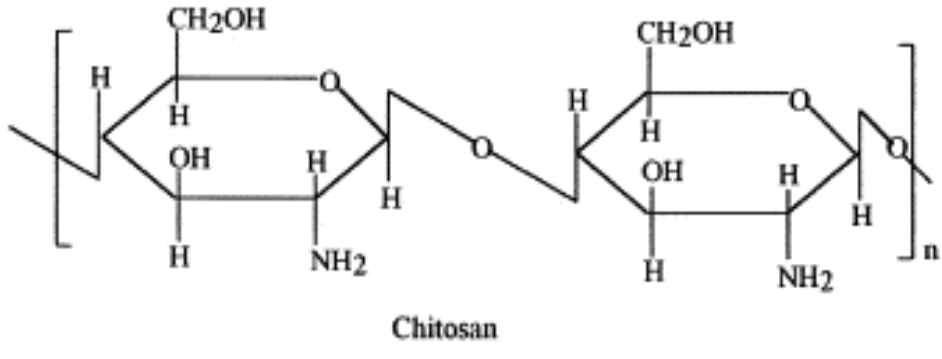
Figure 1. The structural formula of chitosan.